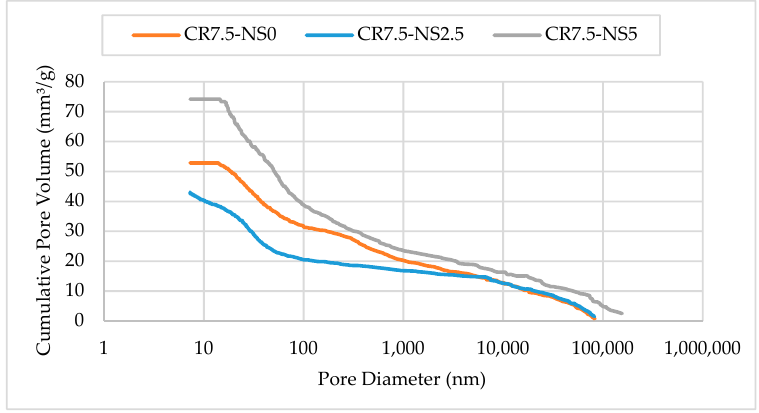
Figure 19. Pore size distribution of NS-CRM samples.